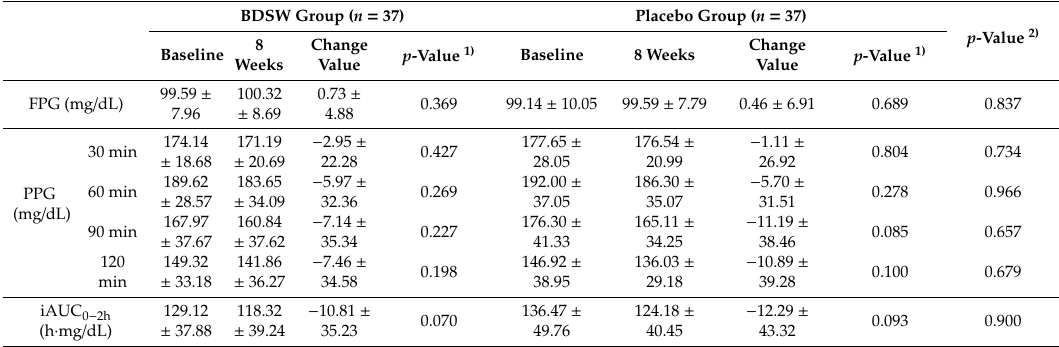
Table 4. Fasting and postprandial glucose changes before and after eight weeks of ingestion.